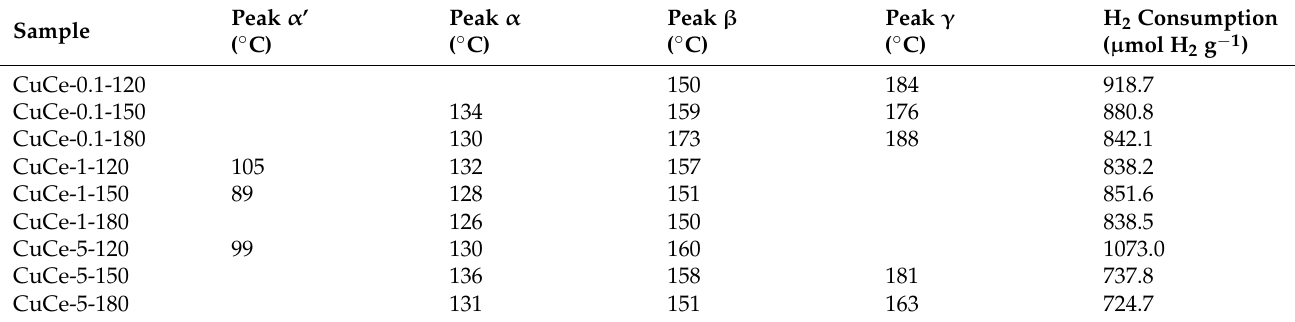
Table 3. Redox properties of CuOCeO 2 catalysts.